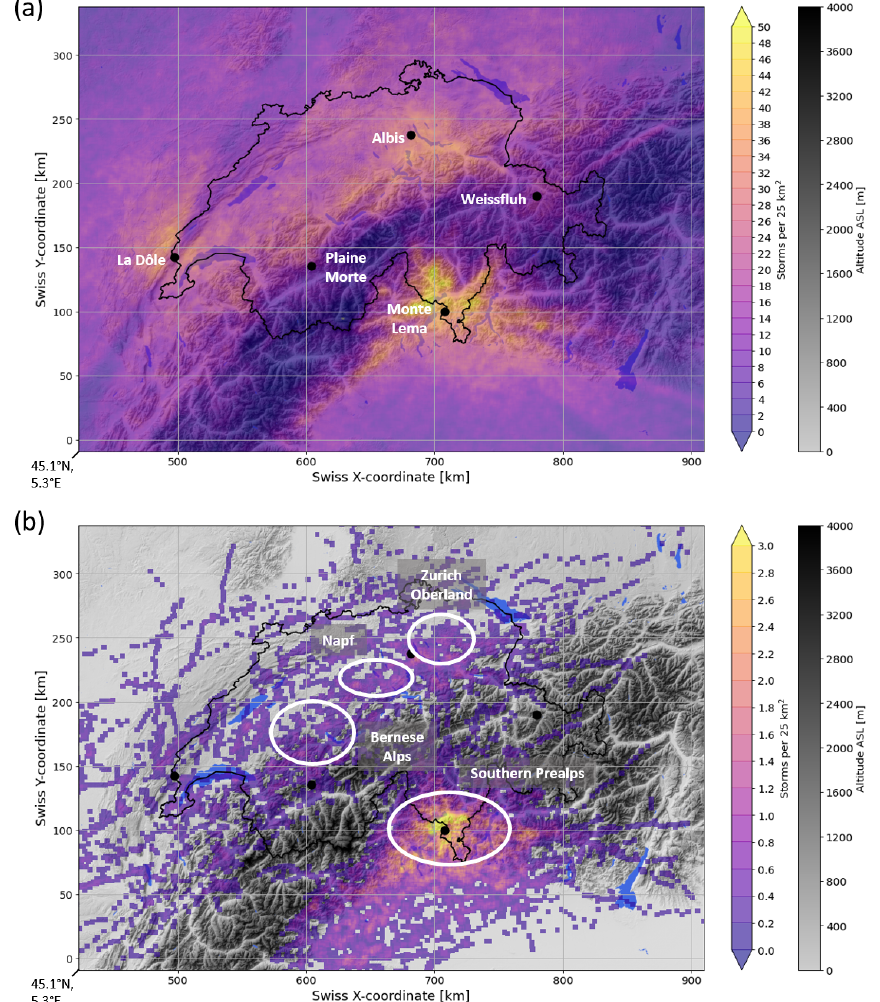
Figure 3. Annual average individual detections of (a) thunderstorms and (b) mesocyclones from 2016–2020 per 25km 2 . Highlighted regions of interest: Zurich Oberland, Napf, Bernese Alps and Southern